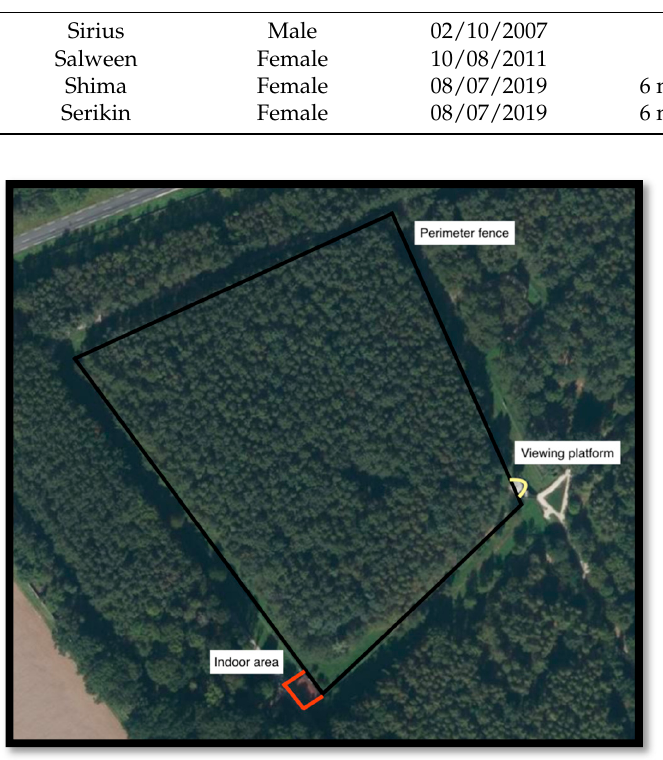
Figure 1. Annotated image of outdoor Malaysian tiger enclosure provided by Parc des Félins.